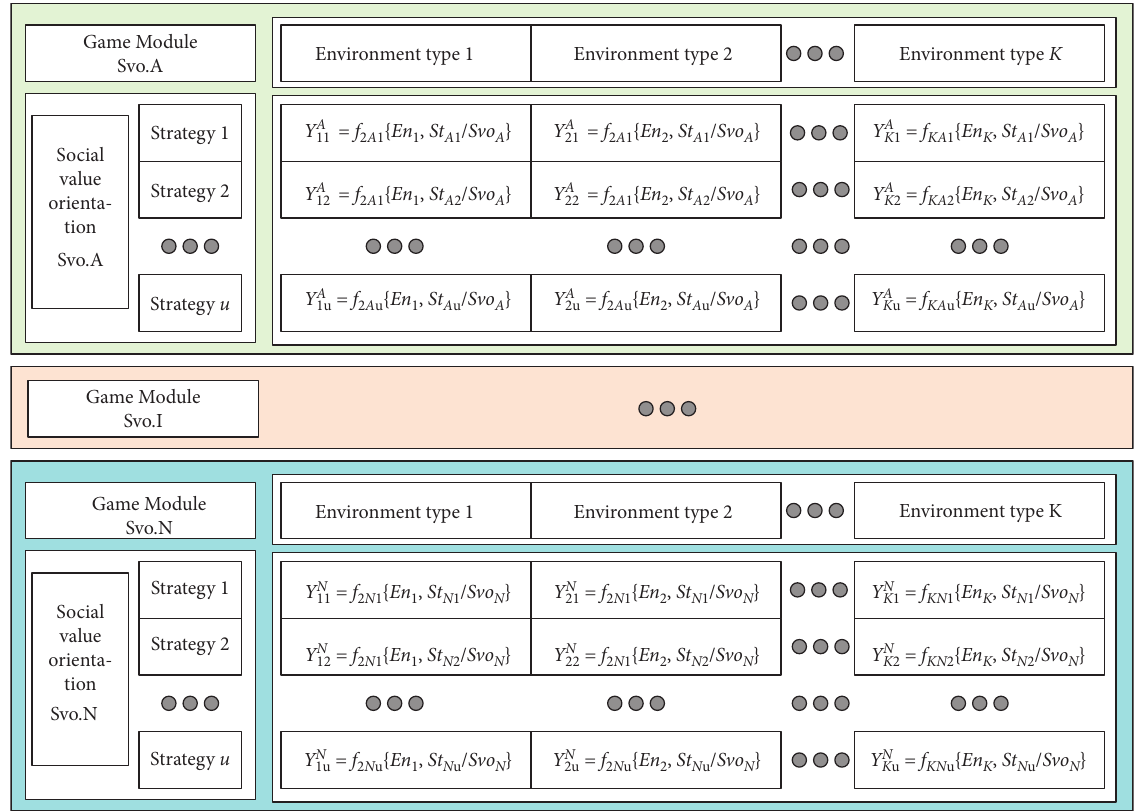
Figure 3: The decision-making game matrix in crisis environment based on SVO differences.